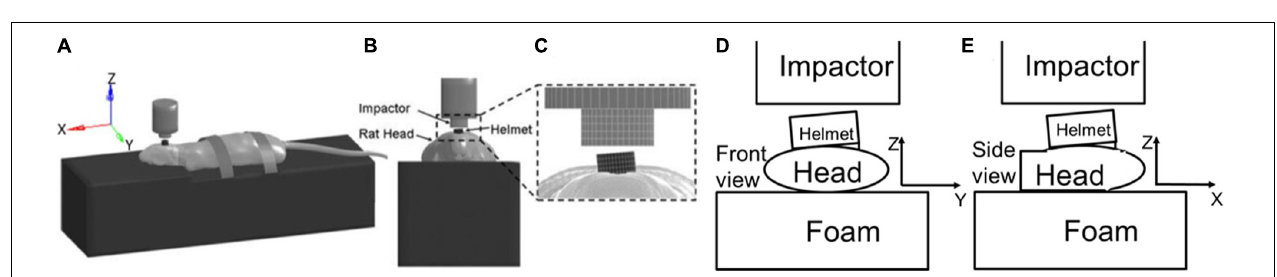
FIGURE 5 | Simulation setup to test the angle effect between helmet and impactor surface. Lateral (A) , anterior (B) , and (C) close up views of the computer model simulation set-up for modified Marmarou rat head impact acceleration experiments, with the helmet rotated 5 ◦ to the side in the coronal plane with respect to the bottom surface of the impactor, (D) Diagram shows helmet rotates at 5 ◦ angle to the impactor in coronal plan, (E) Diagram shows the helmet rotated back angle to impactor in sagittal